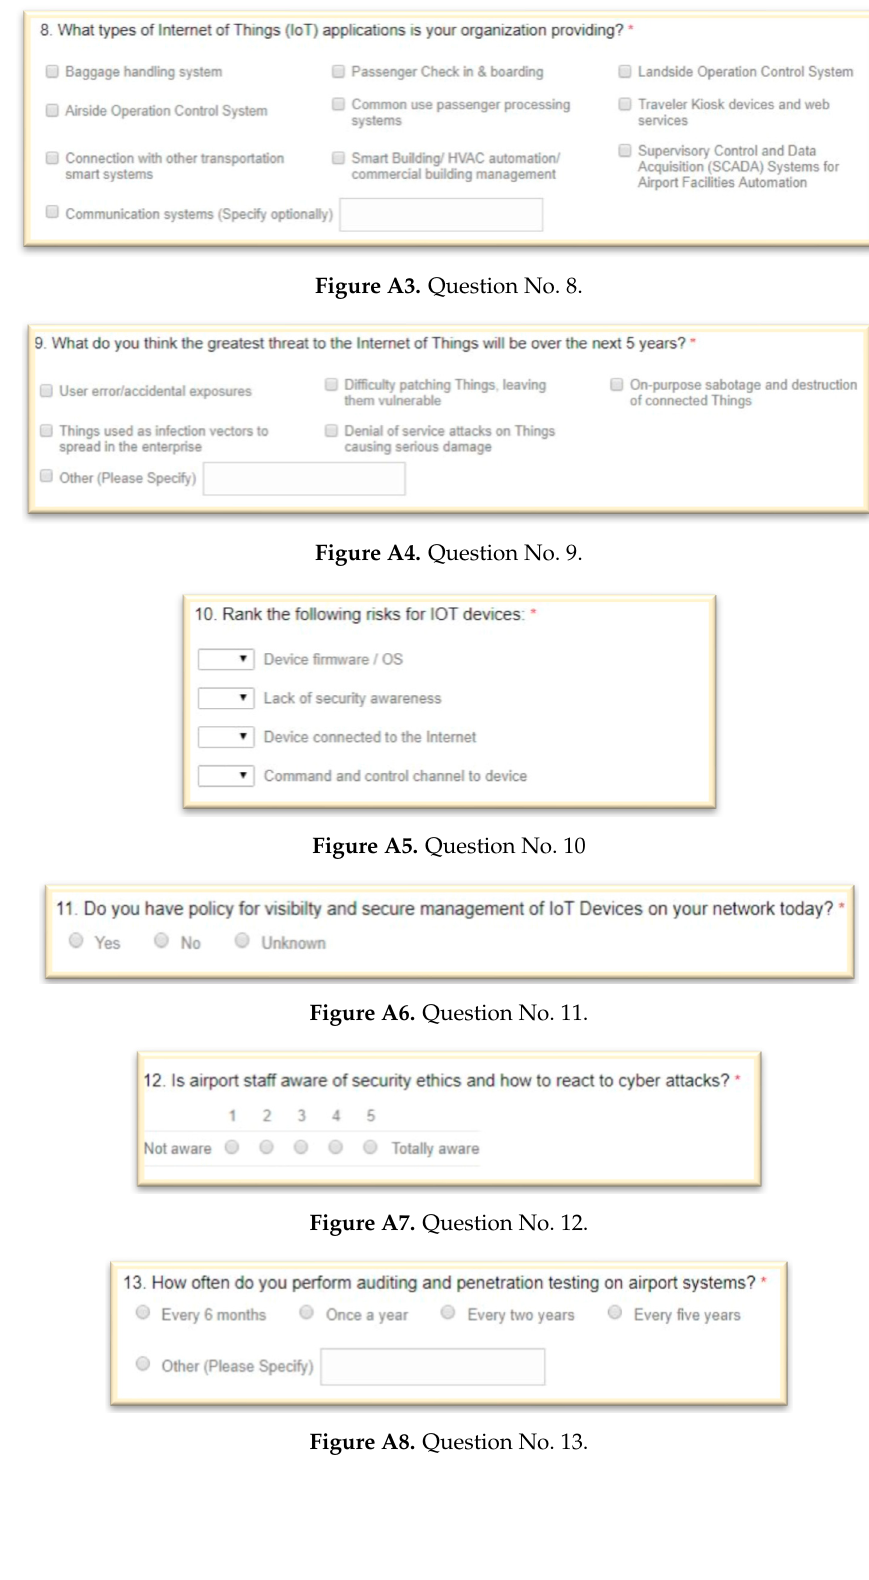
Figure A9. Question No 14. Figure A10. Question No 15. Figure A11. Question No 16. Online Survey Questionnaire Answers and Related Statistics